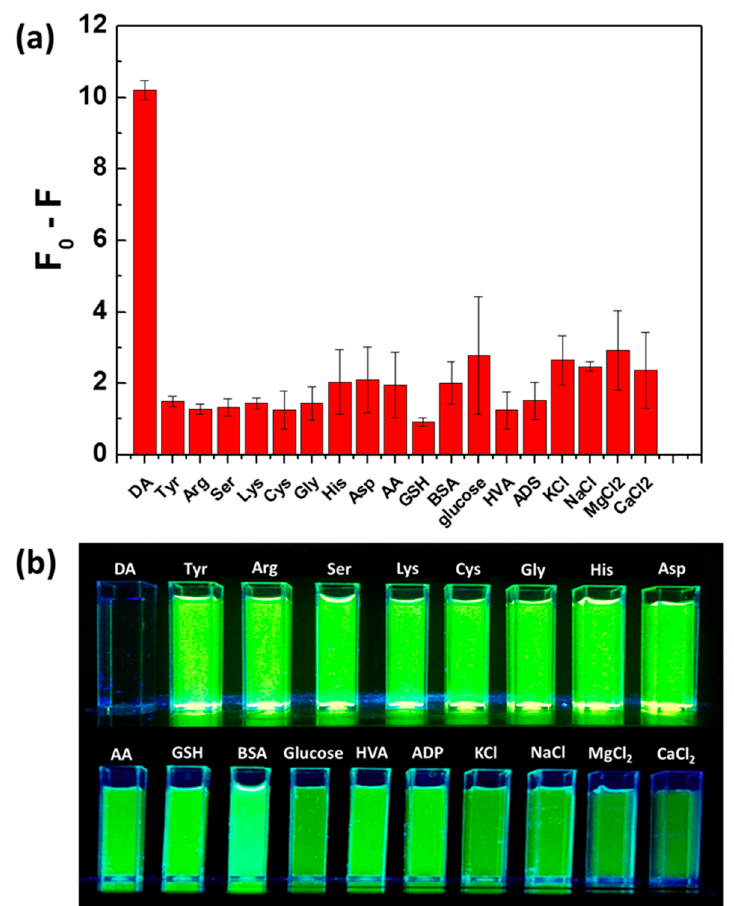
Figure 5. ( a ) QDs@MIP response toward DA and various potential interfering substances. QDs@MIP particles were used at a concentration of 4.3 ng/mL while DA and other substances were used at a 26.3 µM concentration. F 0 and F are the PL intensities of QDs@MIP particles before and after adding DA or the potential interfering substances, respectively. ( b ) Digital photograph taken under UV light irradiation of PBS dispersions of QDs@MIPs after adding DA or the potential interfering substances (contact time of 40 min).